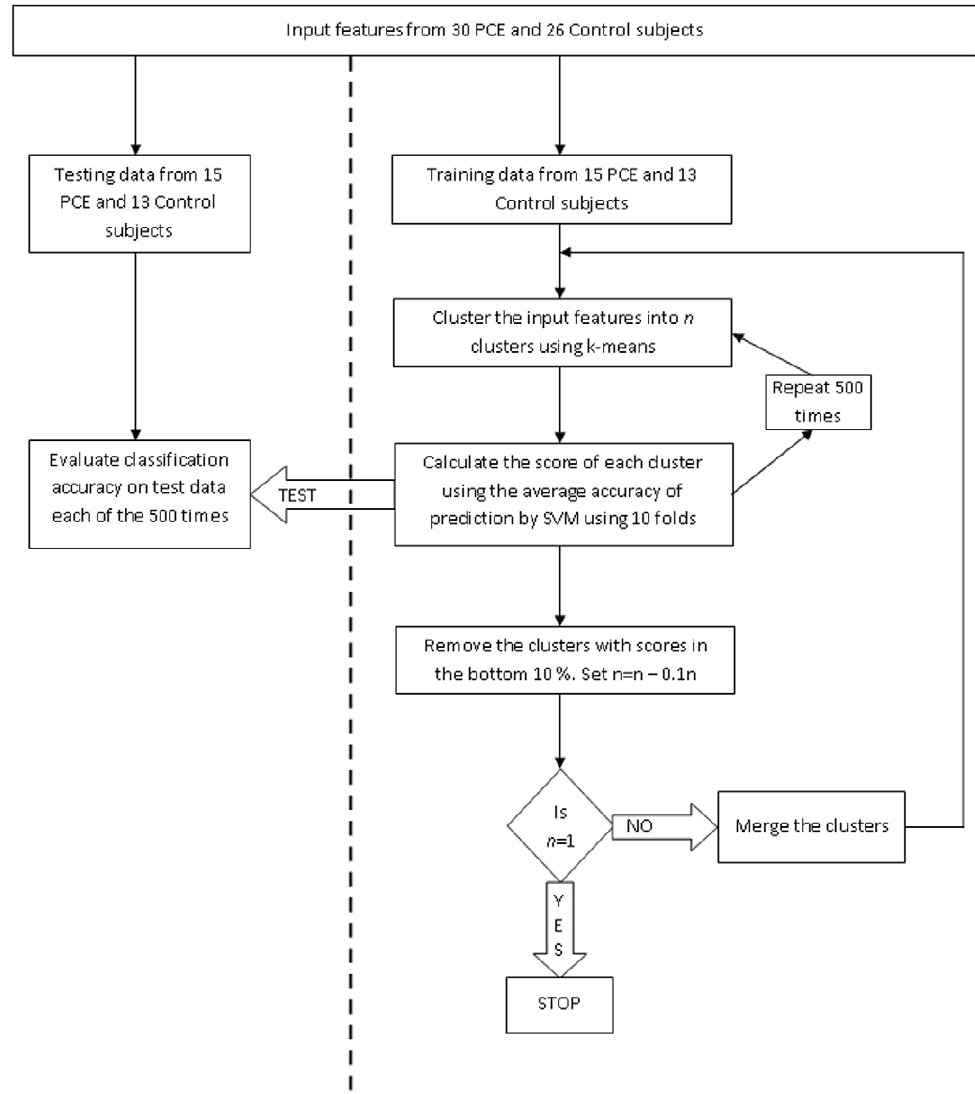
Figure 1. Flow chart depicting the RCE-SVM procedure.